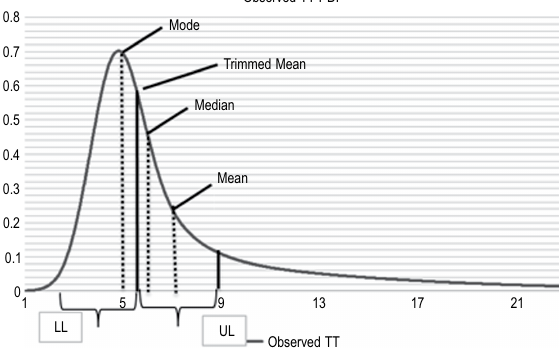
Fig. 2. Probability Distribution Function of travel time (BT observations, private vehicles, public transport vehicles, pedestrian traffic)